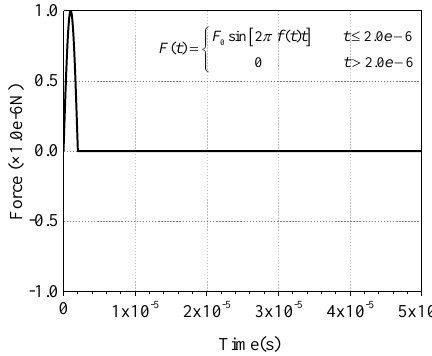
Figure 2. The half-period sine pulse signal.